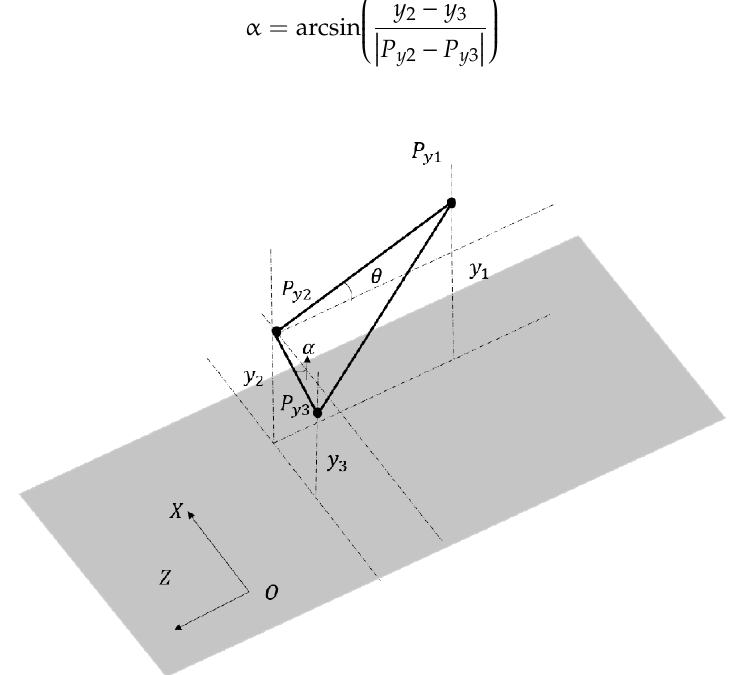
Figure 9. The schematic diagram of the wing flapping and pitching angles.